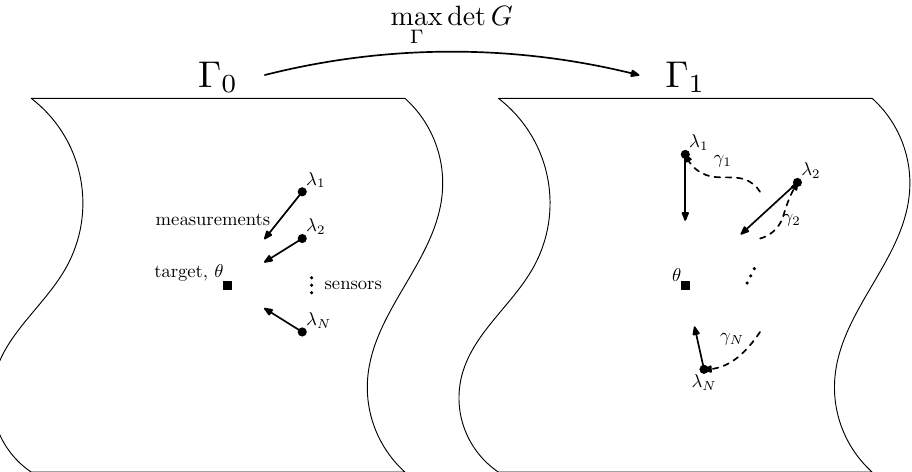
Figure 2. Graphical illustration of D-optimal sensor dynamics; a sensor configuration Γ 0 evolves to a new configuration Γ 1 by moving the N sensors in Ω -space to new positions that are determined by maximizing the determinant of the metric G , given by Equation (14), on the sensor manifold Ω -space to end up in the appropriate positions M ( Γ ) . Each sensor λ i traverses a path γ i through constituting Γ 1 . As shown in Section 4.3, the paths γ i are entropy minimizing if they are geodesic on the sensor manifold M ( Γ ) . Note that the target is shown as stationary in this particular